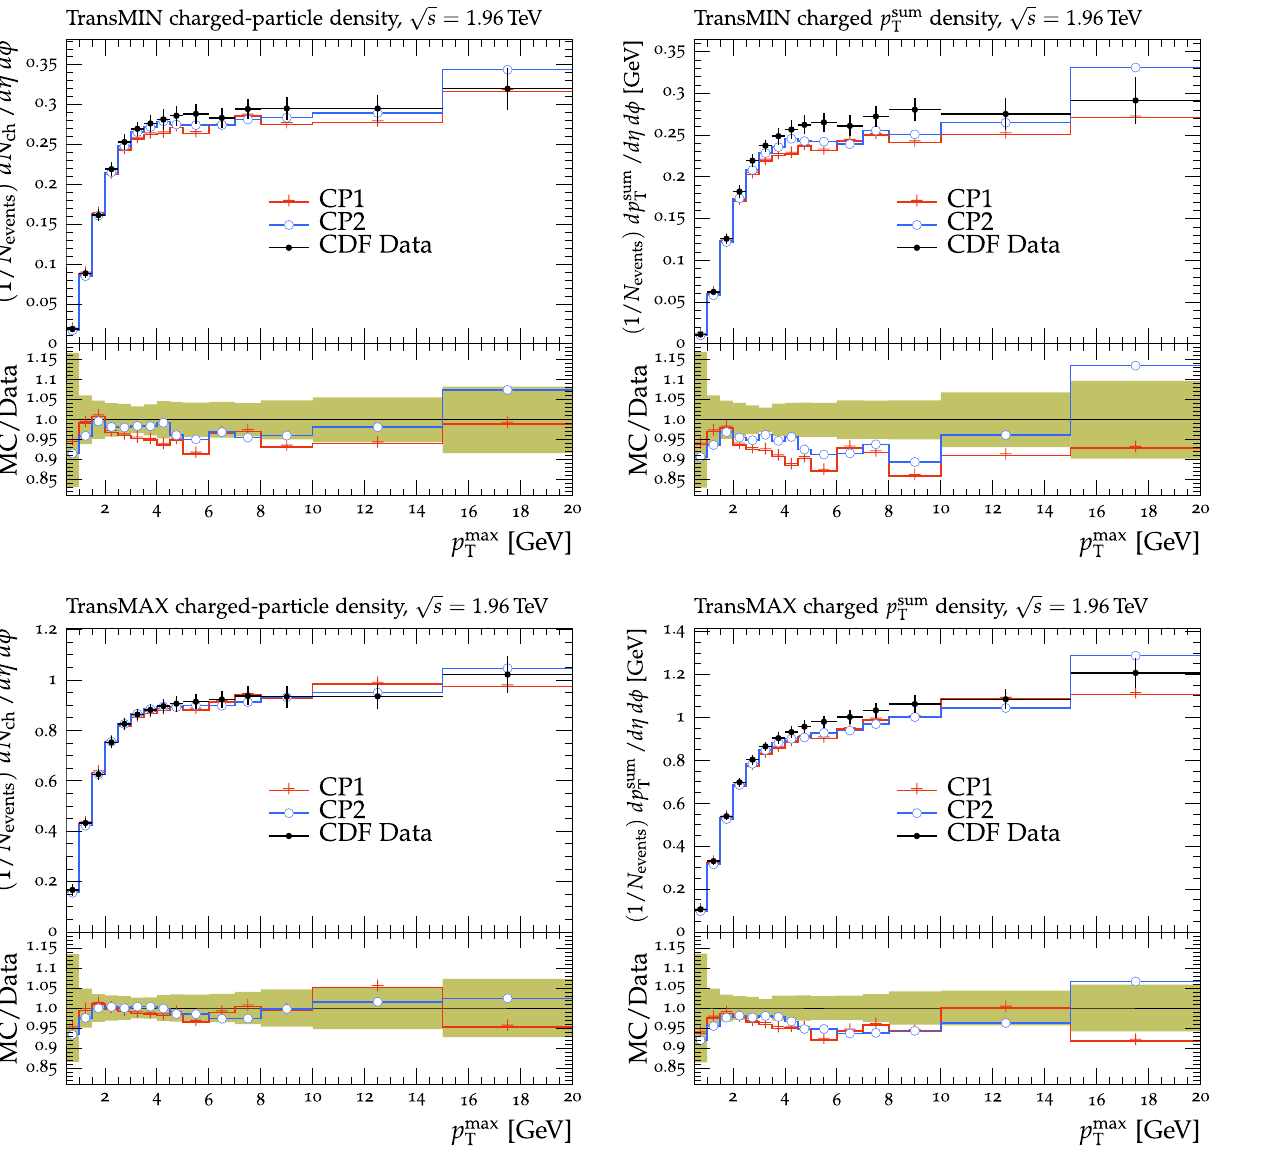
pythia 8 LO-PDF tunes CP1 and CP2. The ratios of simulations to the Fig. 8 The transMIN (upper left) charged-particle and charged p sum T data (MC/Data) are also shown, where the shaded band indicates the (upper right) densities and the transMAX (lower left) charged-particle total experimental uncertainty in the data. Vertical lines drawn on the and charged p sum (lower right) densities, as a function of the trans- T data points refer to the total uncertainty in the data. Vertical lines drawn verse momentum of the leading charged particle, p max , from the CDF √ T s = 1 . 96TeV analysis [9]. Charged hadrons are measured with on the MC points refer to the statistical uncertainty in the predictions. p T > 0 . 5GeV in | η | < 0 . 8. The data are compared with the CMS Horizontal bars indicate the associated bin